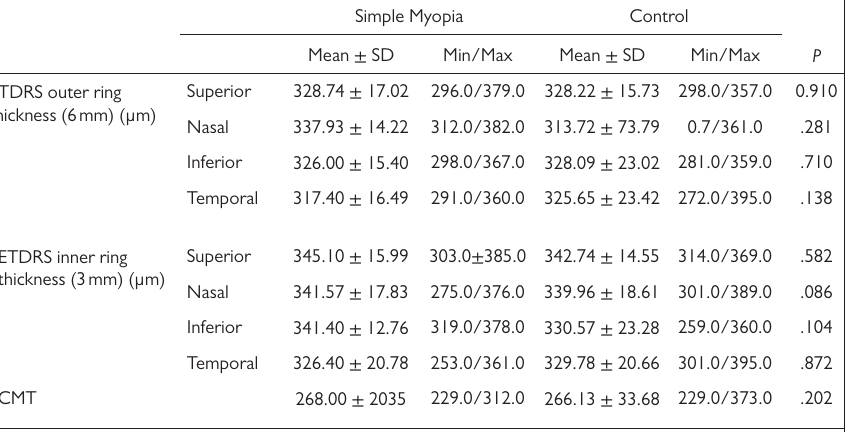
Table 5. Correlations Between SE and AL Values with OCTA